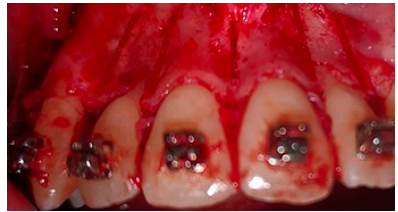
Figure 2. Corticotomy lines.